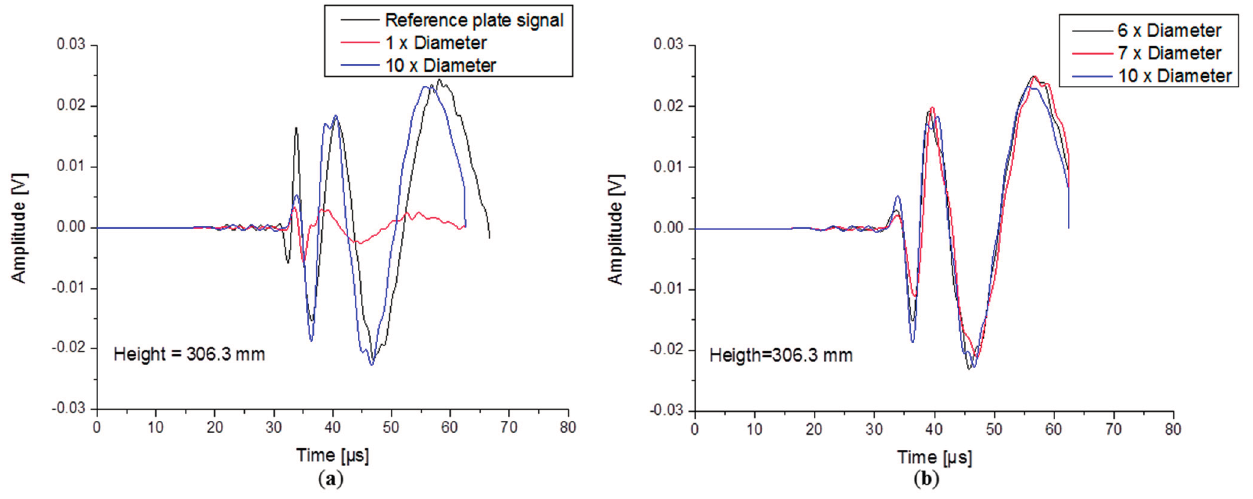
Figure 10. Time domain signals of the ( a ) extreme WG diameter cases and ( b ) intermediate WG diameter